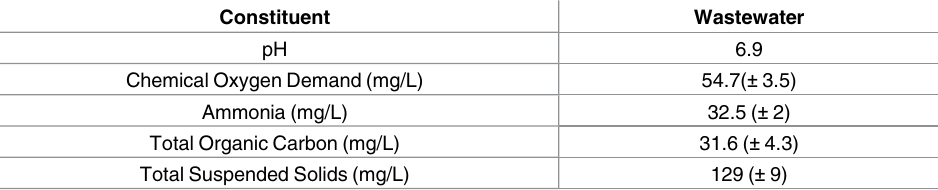
Table 1. Composition of gamma irradiated wastewater. Values in brackets indicate95% confidence